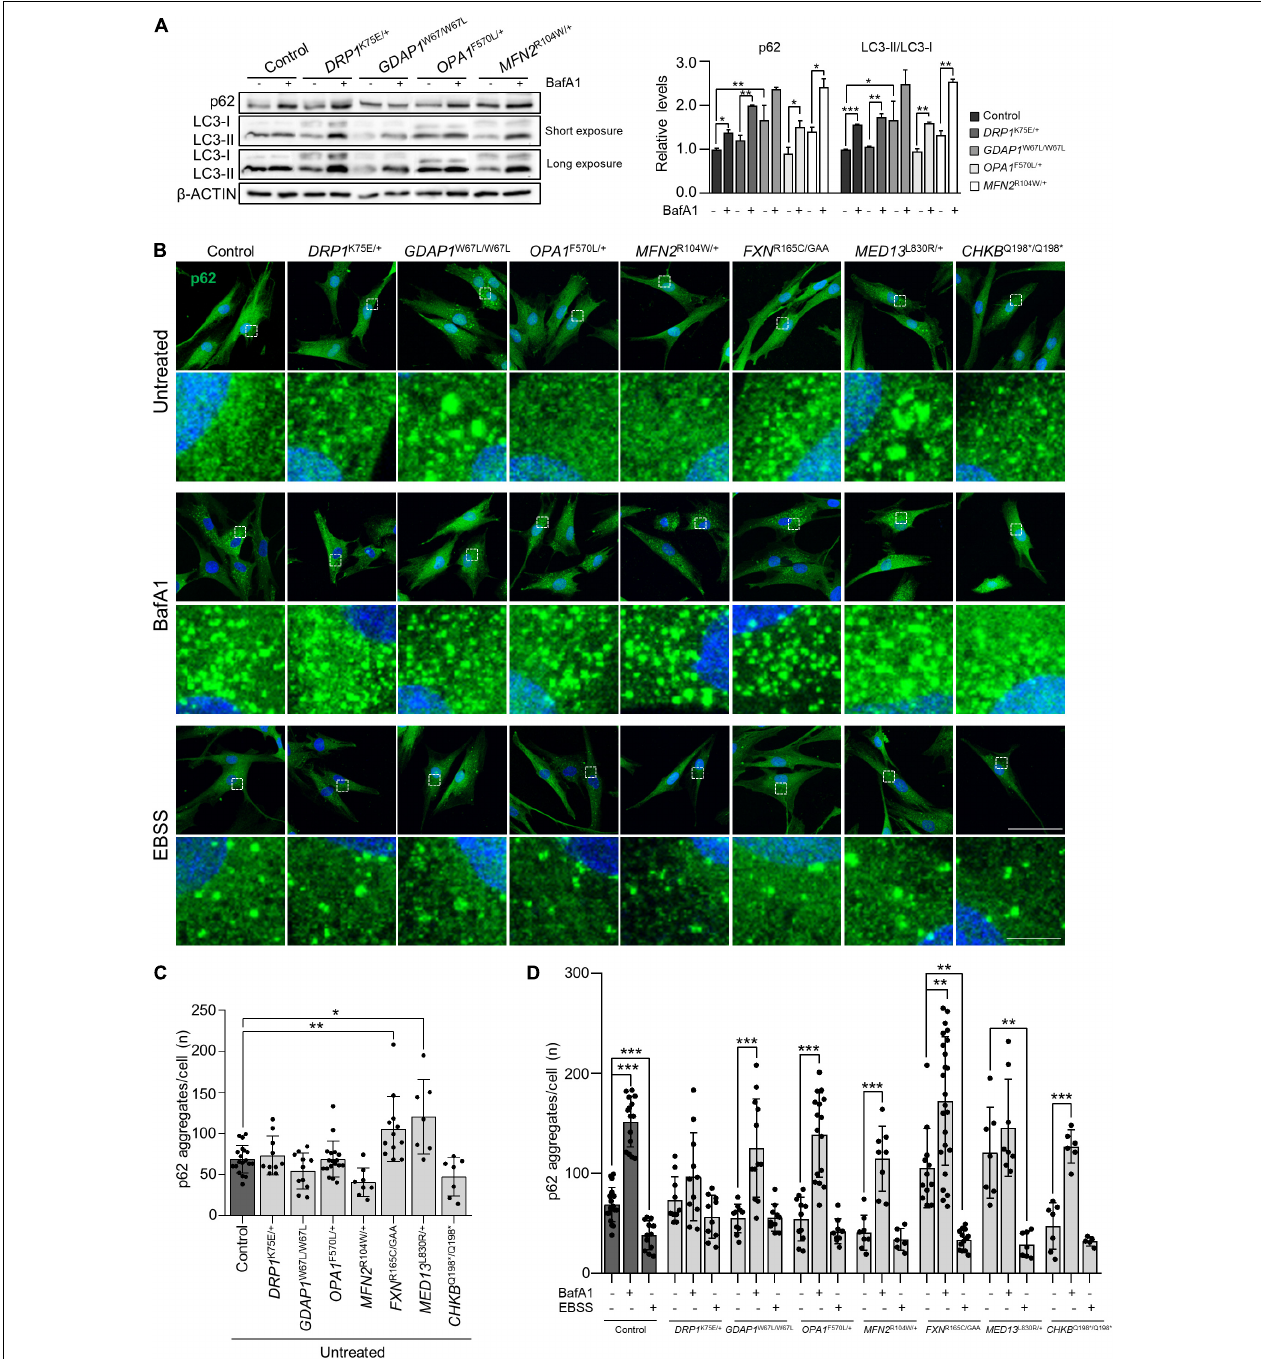
FIGURE 6 | Starvation-induced autophagy was impaired in patients’ fibroblasts with mitochondrial membrane protein defects. (A) p62, LC3-I, and LC3-II relative protein levels in control and mitochondrial dynamic patients’ fibroblasts without treatment and after Bafilomycin A1 treatment. Quantification is shown in the right panel. Data represent mean ± SD. One-way ANOVA followed by Tukey’s multiple comparisons test. Two independent experiments. * P < 0.05, ** P < 0.01, *** P < 0.001. (B) Representative images of autophagic flux marker p62 in untreated fibroblasts and after the inhibition (BafA1) or induction (EBSS) of autophagy. A magnification is shown in the panel below. Scale bars: 75 and 10 µ m (detail). (C) Percentage of p62 aggregates per cell in untreated cells. Data represent mean ± SD and individual values are displayed as dots. One-way ANOVA followed by Dunnett’s multiple comparisons test. Three independent experiments with at least seven slides were analyzed. * P < 0.05, ** P < 0.01. (D) Percentage of p62 aggregates per cell in untreated cells and after BafA1 or EBSS treatment. Data represent mean ± SD and individual values are displayed as dots. One-way ANOVA followed by Tukey’s multiple comparisons test. Three independent experiments with at least seven slides were analyzed. ** P < 0.01, *** P <